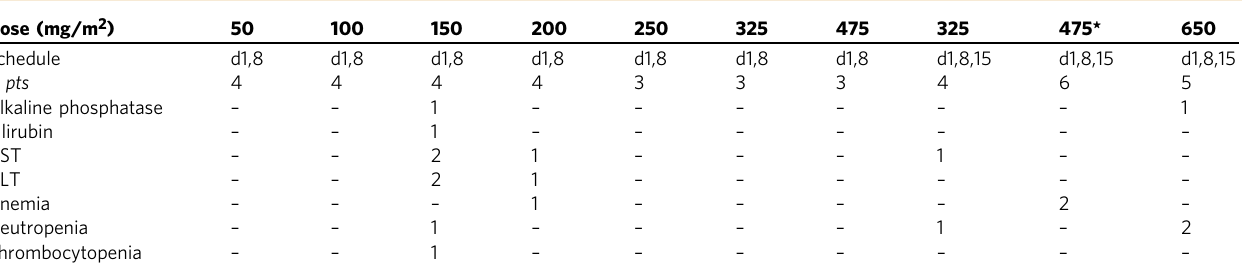
Table 4 Hematology and biochemistry.